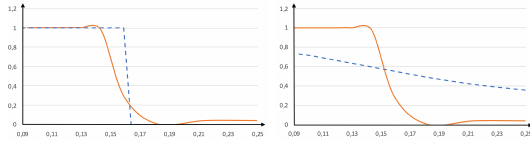
Figure 7. P 2 versus P 3 for the smooth case. Comparison between the statistical frequencies (full) and the two probabilistic laws (dotted). 500 meshes are used for each value of h . Left: comparison with the two-steps probabilistic law (2.5) – Right: comparison with the sigmoid probabilistic law